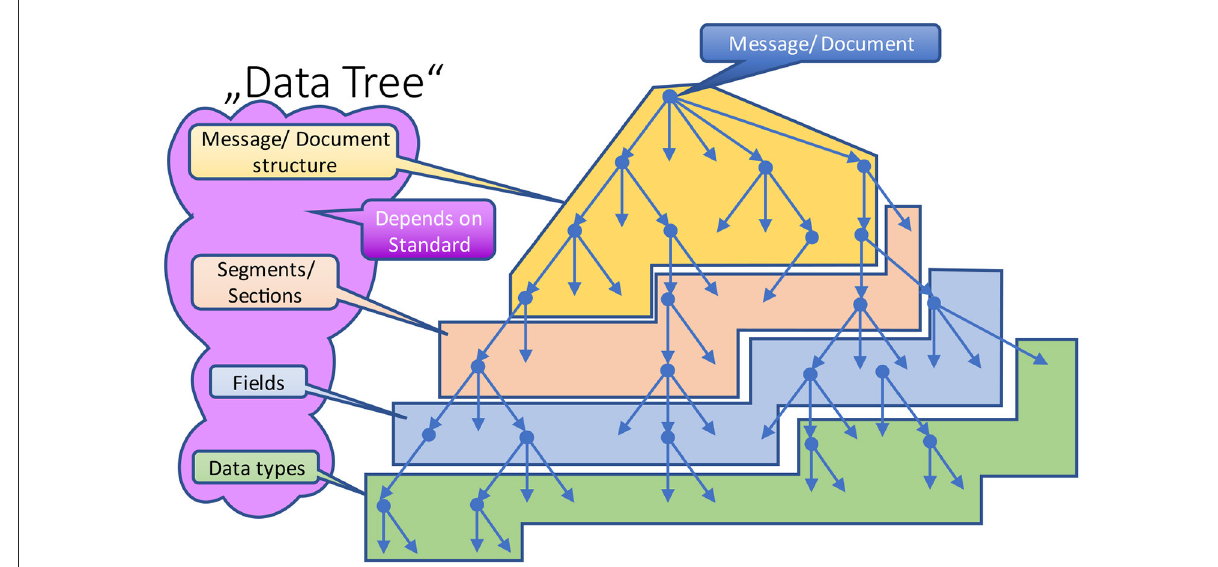
FIGURE7 Abstract data tree.